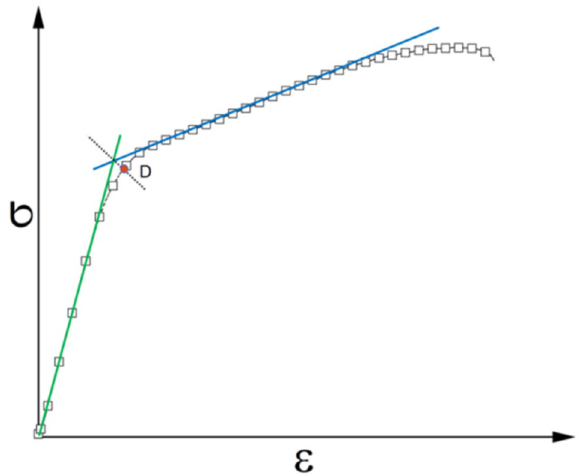
Figure 11. Determination method of dewetting point.